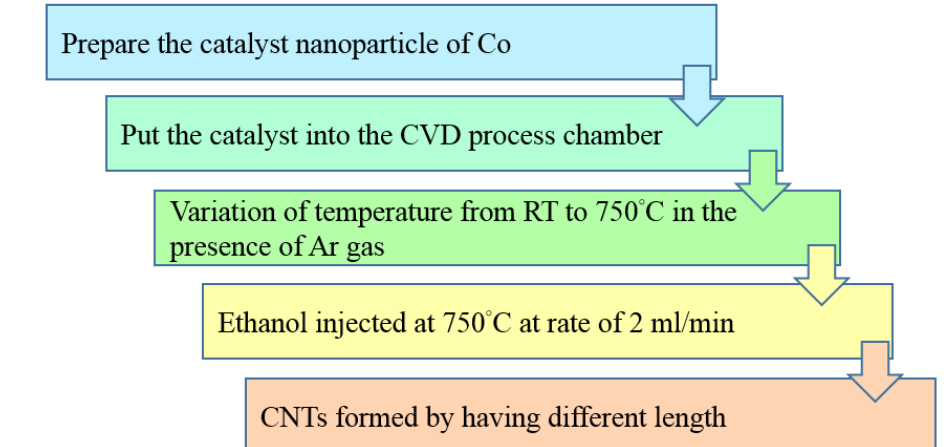
Figure 10. Schematic process flow of MWCNTs formation using CVD method.